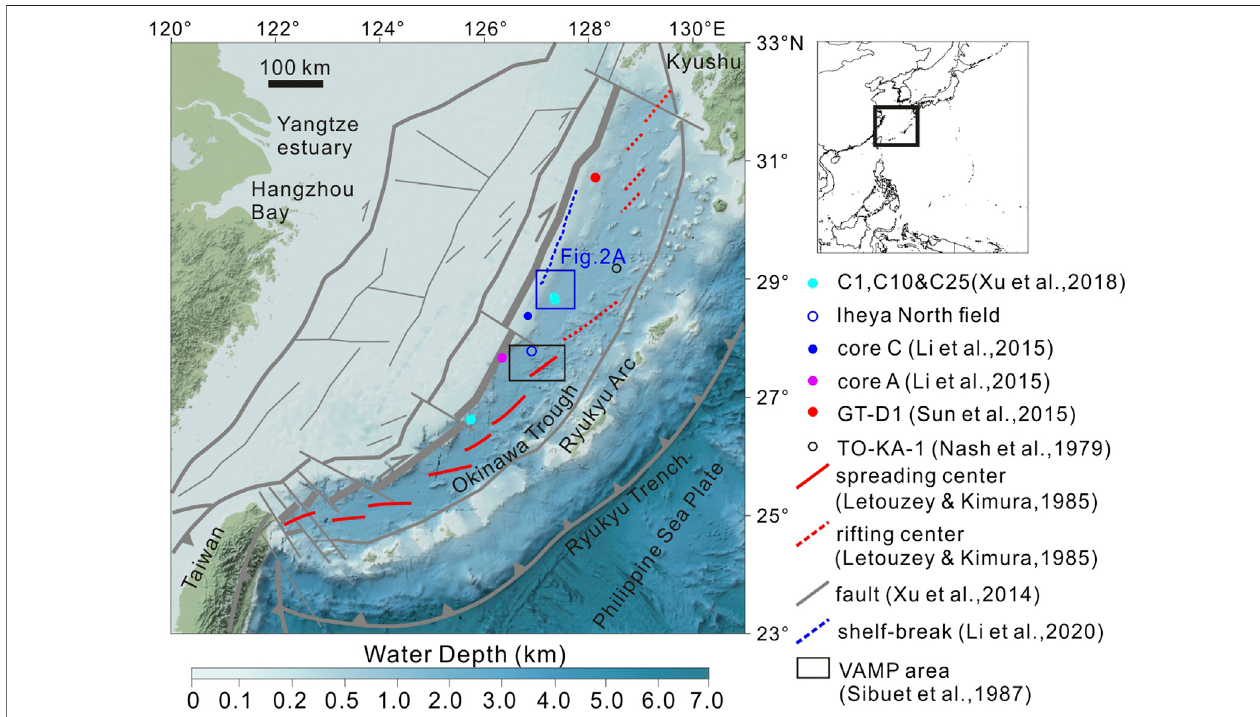
FIGURE 1 | Bathymetric map showing the study area in the Okinawa Trough. The bathymetric data are downloaded from https://maps.ngdc.noaa.gov/viewers/ bathymetry(colorbar — GEBCO2014BathymetryColorScale).ThemethaneseepageshavebeenrecordedatthesitesofCoresAandC,C01,C10andGT-D1(Lietal., 2015; Sun et al., 2015; Xu et al., 2018).